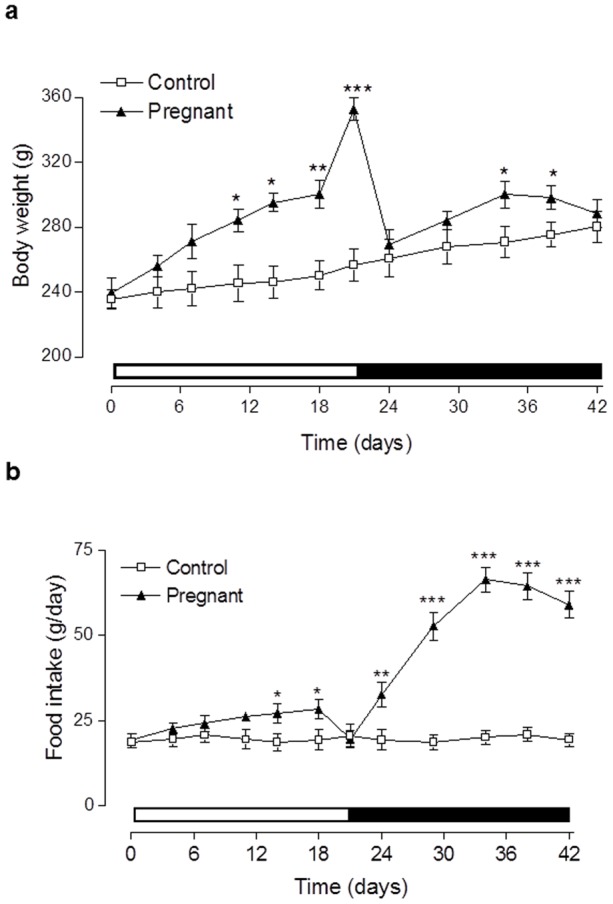
Effects of pregnancy and lactation on (a) body weight and (b) food intake in Wistar rats.Parameters were measured for 21(indicated by open bar) and 21 days subsequent to parturition (indicated by black bar). Values are means ± SEM for 6 rats. * p<0.01, **p<0.01 and *** p<0.001 compared to controls.